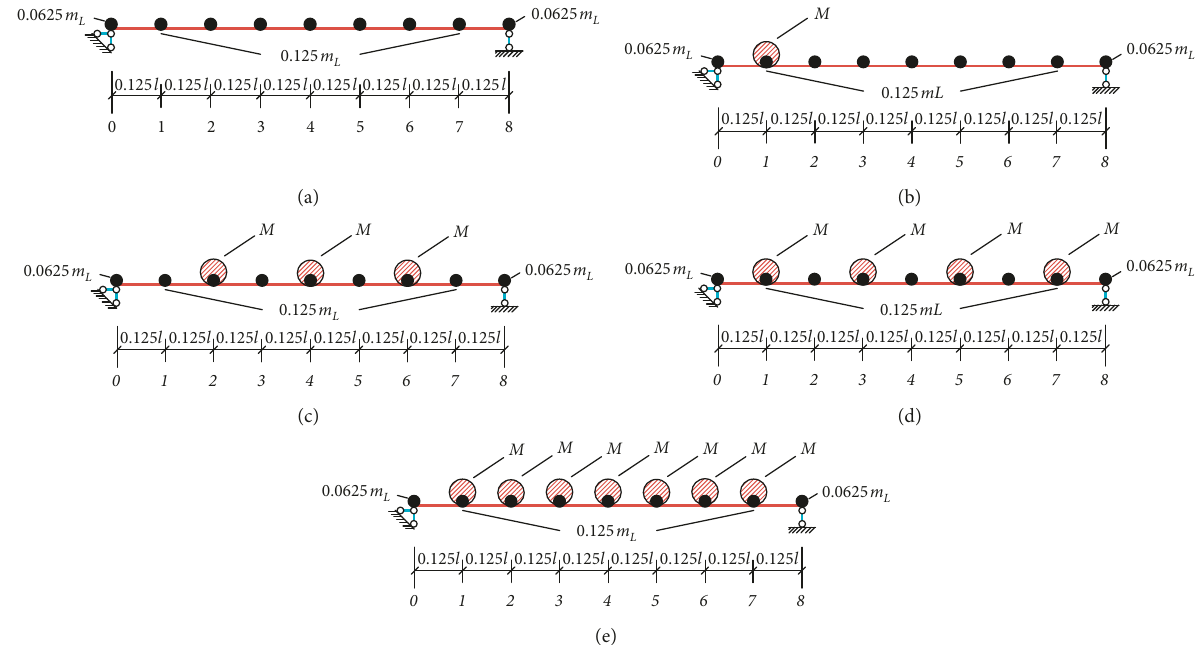
Figure 2: The simplified model: (a) preliminary model; (b) model with 1 concentrated mass; (c) model with 3 concentrated masses; (d) model with 4 concentrated masses; and (e) model with 7 concentrated masses.